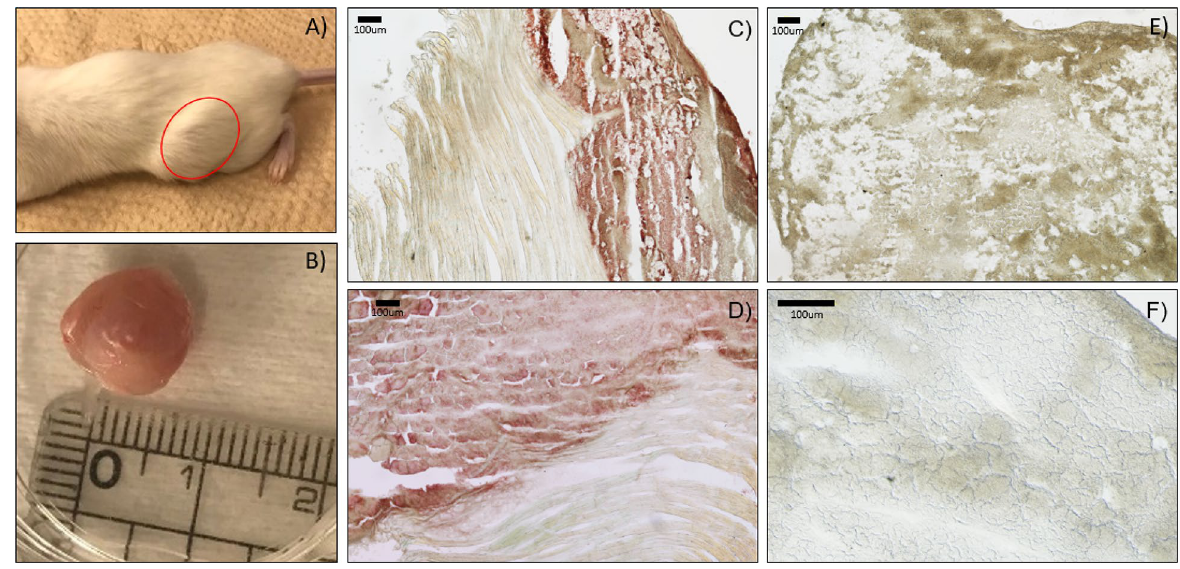
Figure 4. Tumor engraftment and immunohistochemistry. ( A ) Palpable tumors formed at 4–5 weeks after subcutaneous injection of BZ cells into the flank of NOD-scid mice were ( B ) removed and ( C , D ) cryosectioned for immunohistochemistry. ( E , F ) HEK cell derived tumor were similarly grown, removed and section. Positive IHC staining of BZ tumor sections was observed with ( C ) anti-lambda light chain and ( D ) anti-IgM heavy chain at the location of the tumor but not stained in the adjacent muscle tissue. In contrast, HEK derived tumors exhibited a negative signal for ( E ) anti-lambda light chain and ( F ) anti-IgM heavy chain IHC